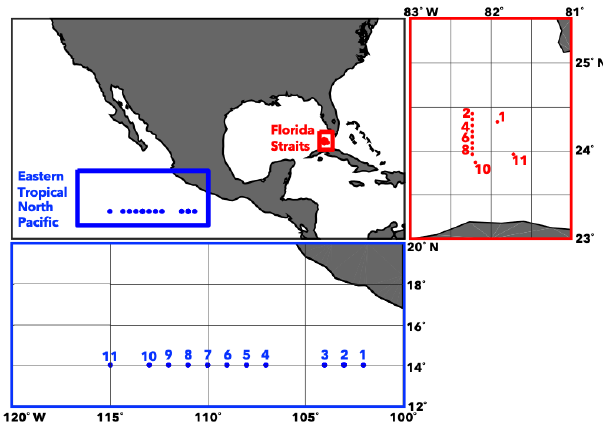
Figure 1. Sample locations. Locations of 11 samples in both the eastern tropical North Pacific (June–July 2018) and the Florida Straits (March 2018). Microlayer and subsurface samples were col- lected at each